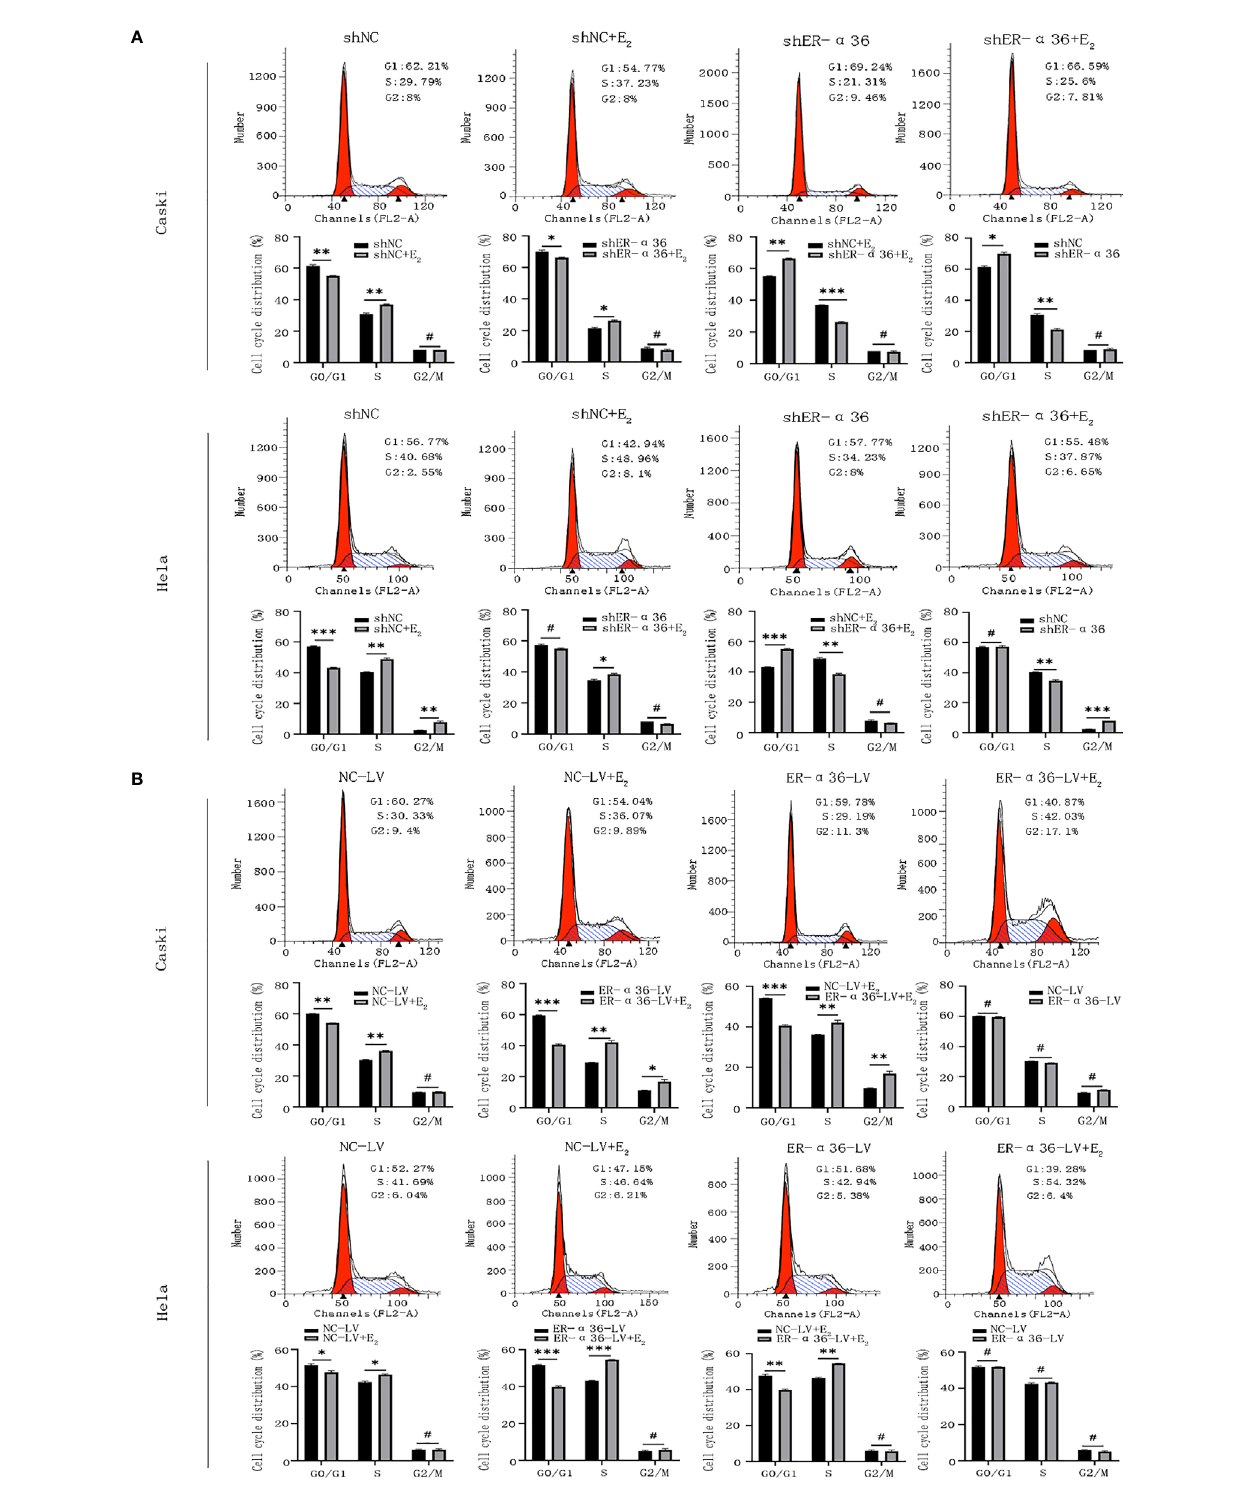
FIGURE 4 | ER- a 36 is involved in E 2 stimulated cell cycle progression. Caski and hela cells transfected with shNC, shER- a 36, NC-LV and ER- a 36-LV were treated with ethanol or 1nM E 2 for 24 h in cell cycle assay. (A, B) Cell cycle analysis was performed by fl ow cytometry. Cell cycle phase distribution was expressed as a percentage of total cells as shown. (Data are mean ± SEM, # p > 0.05, *p < 0.05, **p < 0.01, ***p < 0.001,